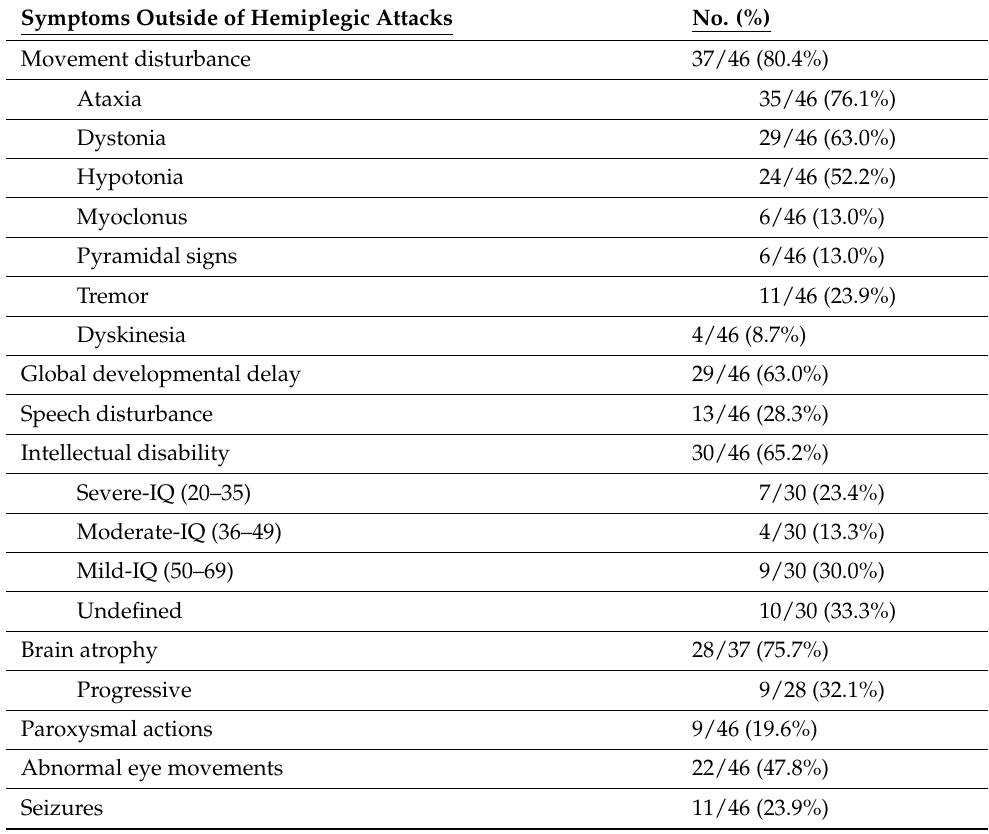
Table 4. Reported symptoms outside of hemiplegic migraine attacks